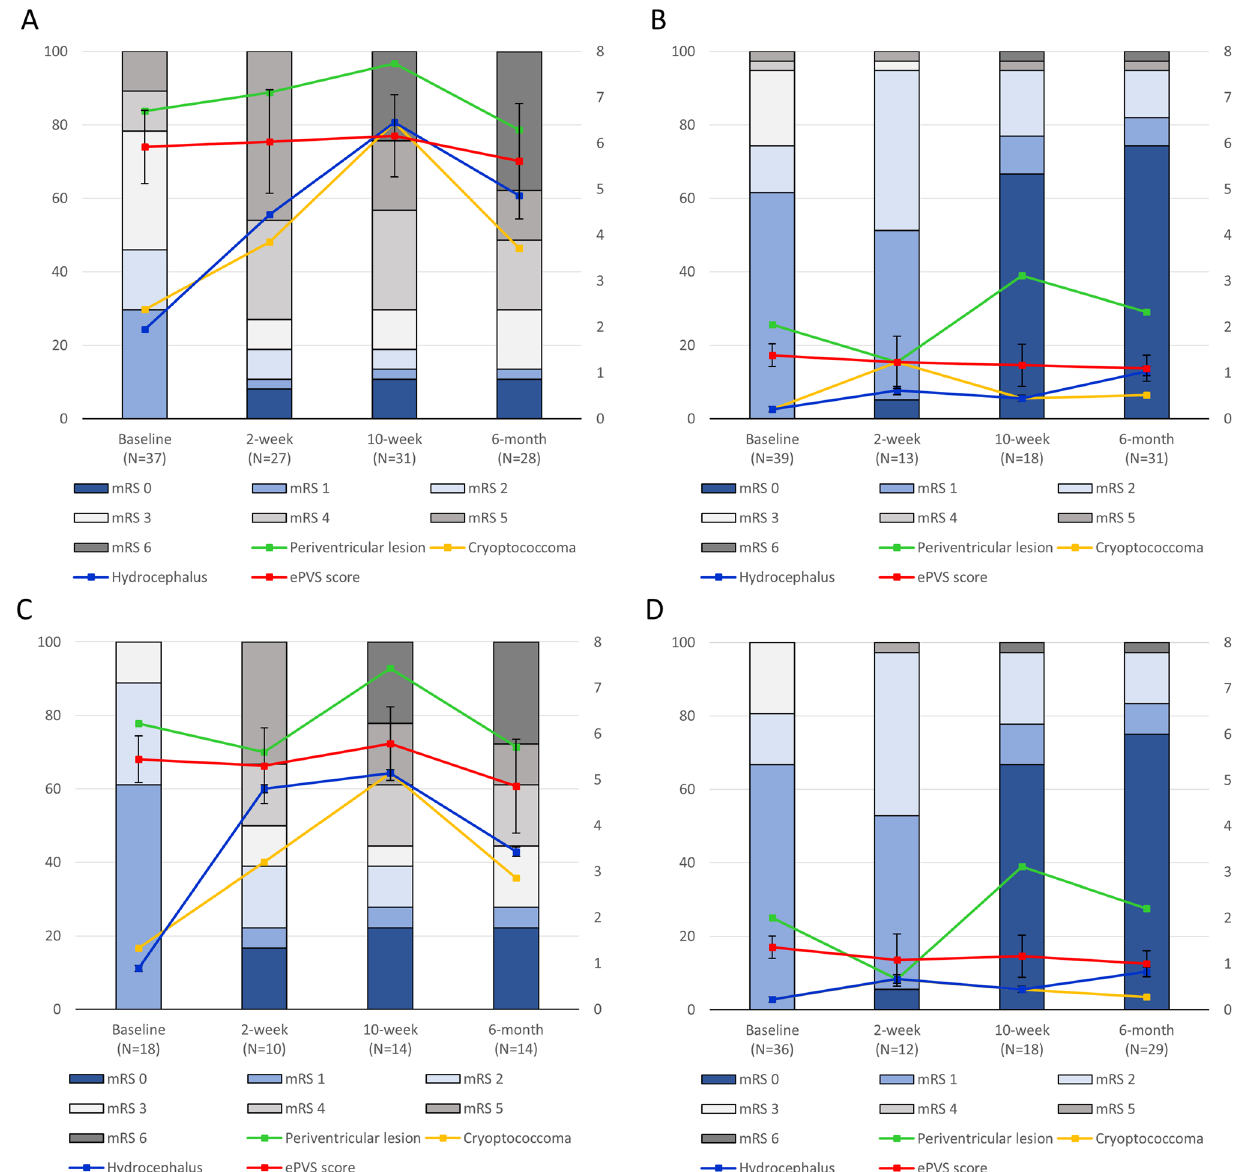
Figure 3. Serial changes in the MRI parameters and the modified Rankin scale (mRS) scores. Panel ( A ) demonstrates the subgroup with baseline ePVS score ≥ 5 (n = 37) and Panel ( B ) describes the subgroup with baseline ePVS score < 5 (n = 39) in the whole study population (n = 76). Panel ( C ) demonstrates the subgroup with baseline ePVS score ≥ 5 (n = 18) and Panel ( D ) describes the subgroup with baseline ePVS score < 5 (n = 36) in the subgroup without baseline encephalitis feature (n = 54). The bar graph indicates the modified Rankin scale (mRS) score profiles and the line graphs indicates the changes in the frequency of each MRI findings and the changes in the total enlarged perivascular space (ePVS)score. The numbers in the X axis indicates the number of patients included in the MRI analysis in each time point. Every patient was included in each time point of the mRS